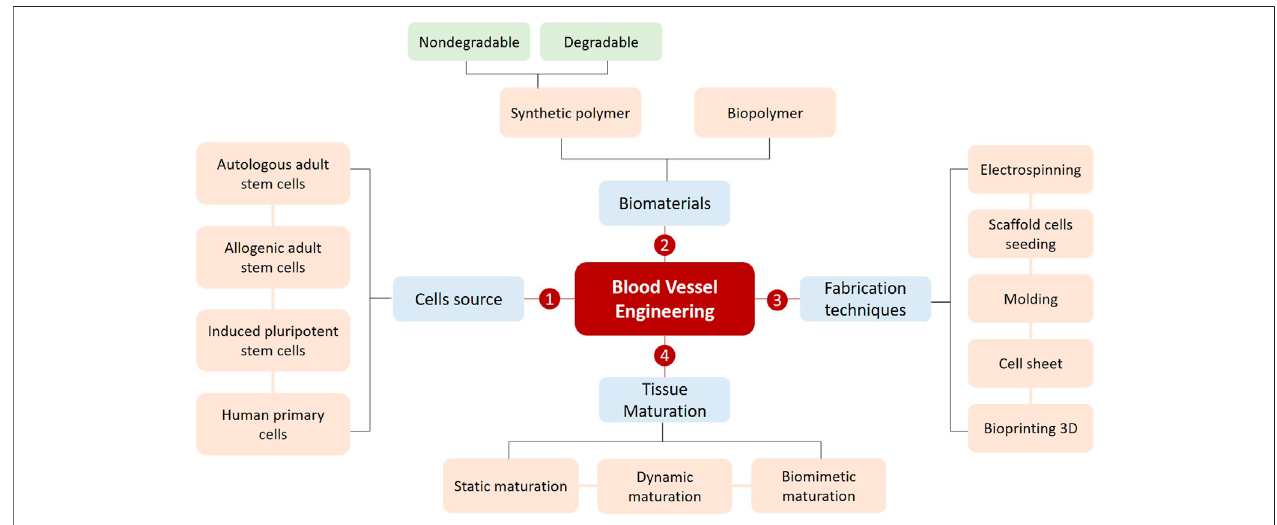
FIGURE 1 | The fundamentals principles for successfully creating a blood